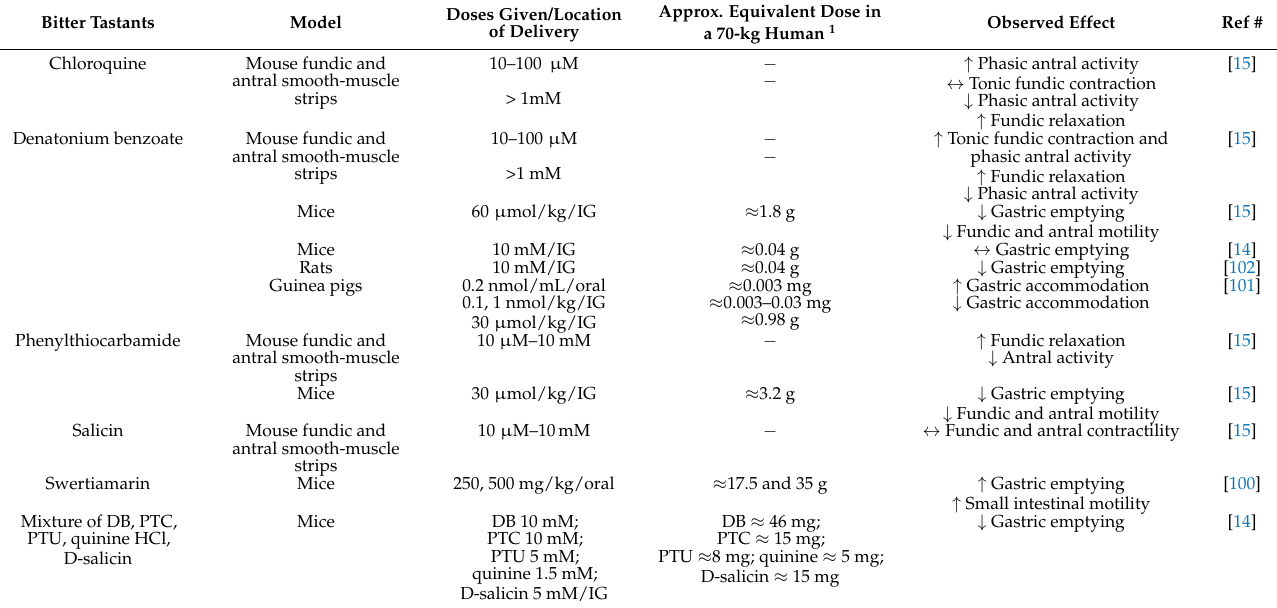
Approx. Equivalent Dose in a 70-kg Human 1